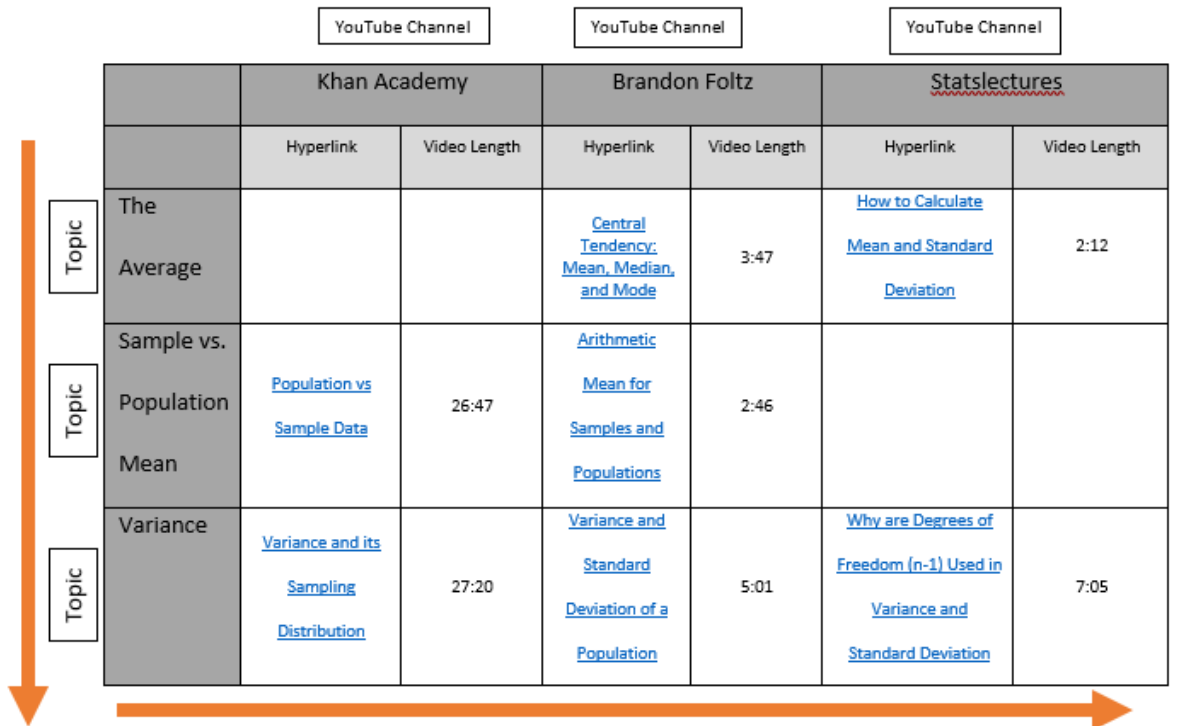
Figure 2: Schematic of the Euclid Statistical